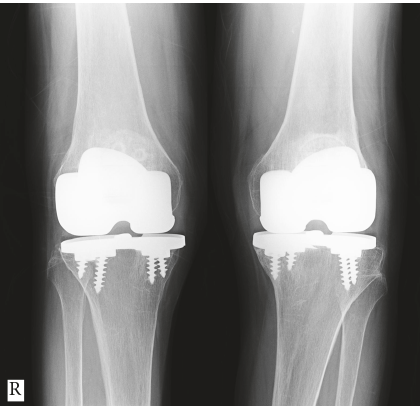
Figure 2: Follow-up plain radiograph obtained 15 years after surgery shows no change in the alignment of the right side and obvious deterioration of the varus malalignment (FTA of 190 ∘ ) of the left